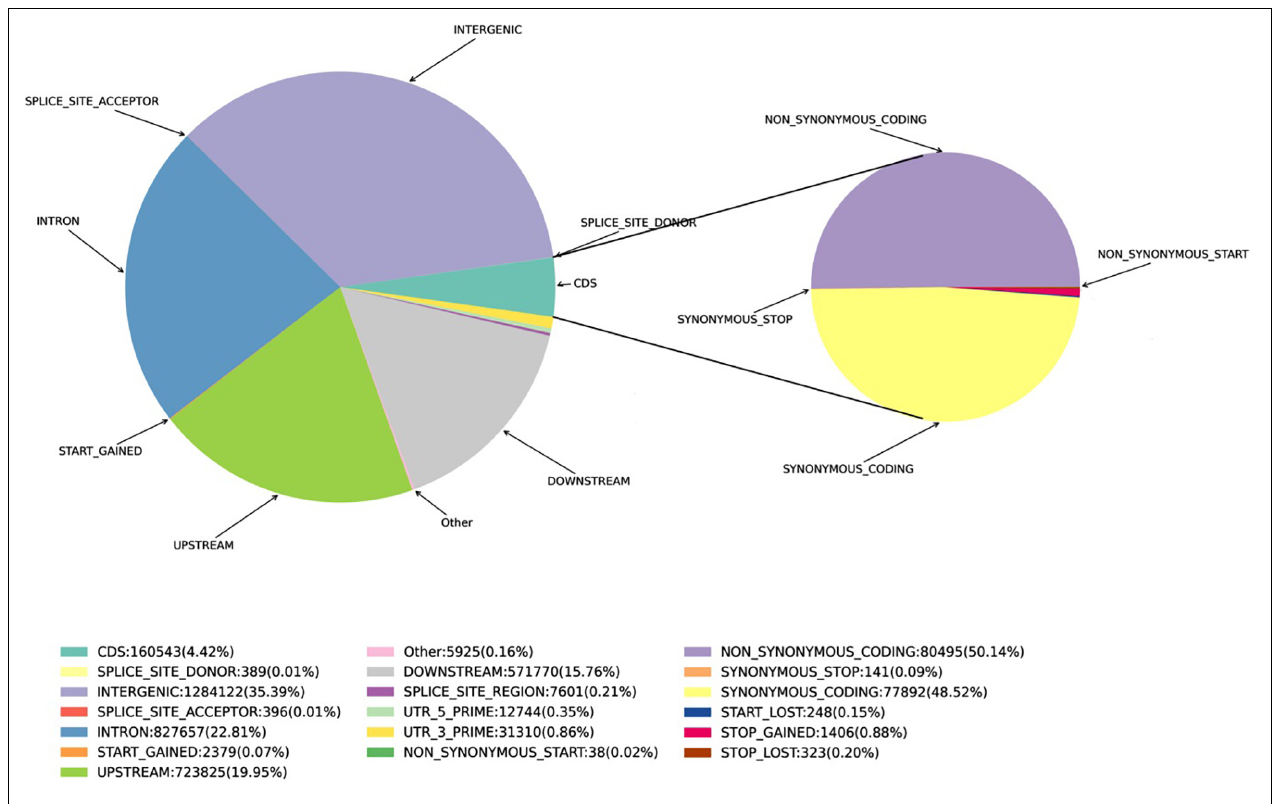
FIGURE 1 | Proportions of the various SNPs in the Munake cultivar and the reference genome of V. vinifera.